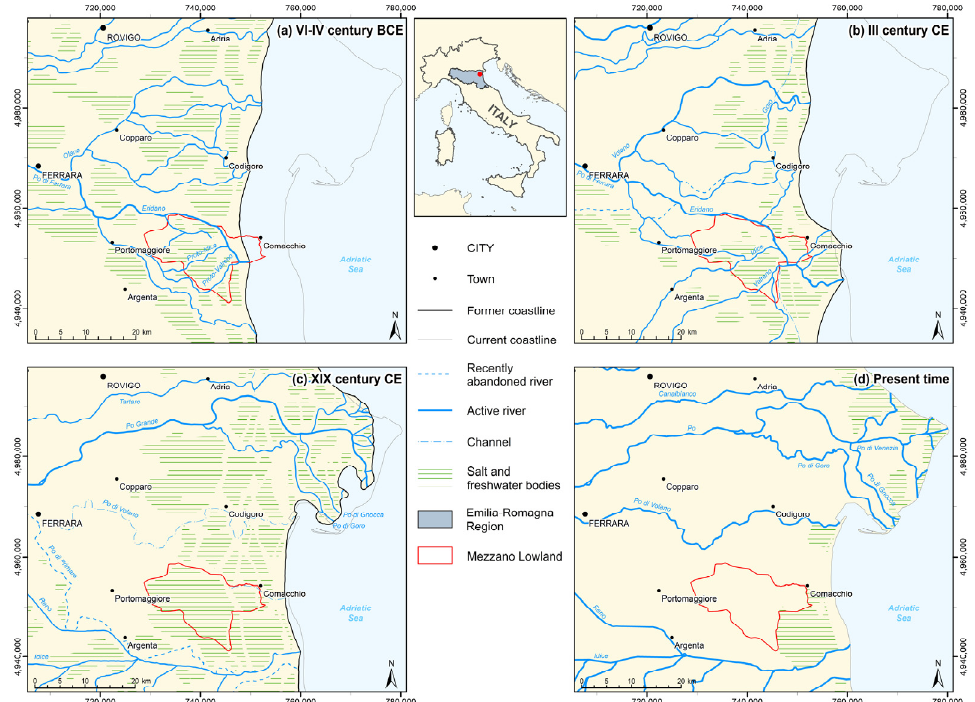
Figure 1. The Po plain area near the Mezzano Lowland in the VI-IV century BCE ( a ) III century CE ( b ), XIX century CE ( c ) and its current setting ( d ). For the tracing of the area’s evolution, historical maps from local archives [30] were adopted and simplified. For each period, the main hydrographic features and coastline are shown; current placement of cities, towns and coastline, together with the limits of the Mezzano Lowland study area are reported in all panels. Cartographic reference systems: WGS 84 and UTM Zone 32N.